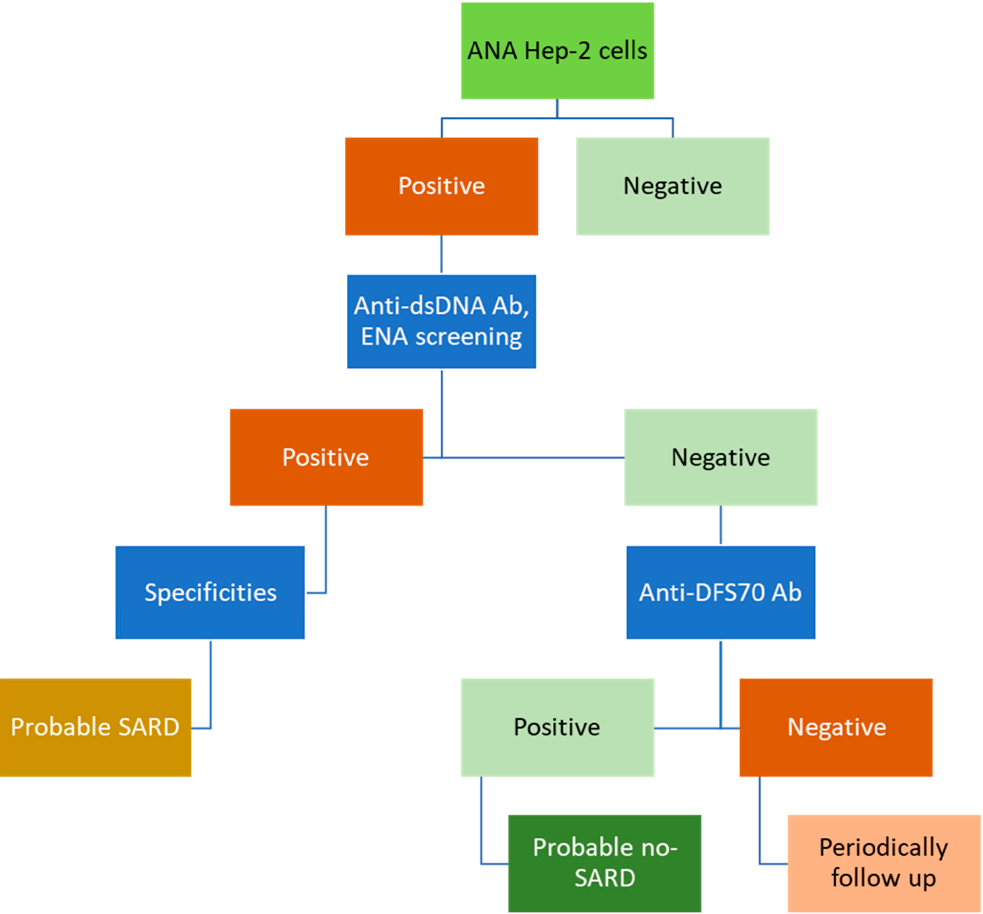
Figure 1. Conventional algorithm for ANA screening at present by using screening with IIF on HEp-2 cells.